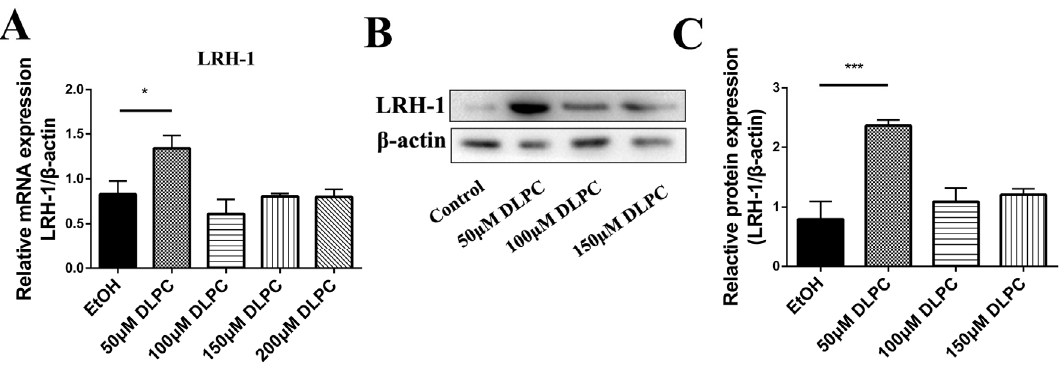
Figure 2. DLPC induced LRH-1 expression. ( A ) The mRNA levels of LRH-1 in granulosa cells by treatment with various concentrations of LRH-1 agonist (DLPC). ( B ) Western blotting of LRH-1 protein in granulosa cells by treatment with various concentrations of DLPC. ( C ) The protein levels of LRH-1 in the different groups. Data are expressed as the mean ± SEM from three biological replicates. * p < 0.05, *** p < 0.001, comparing the indicated groups.